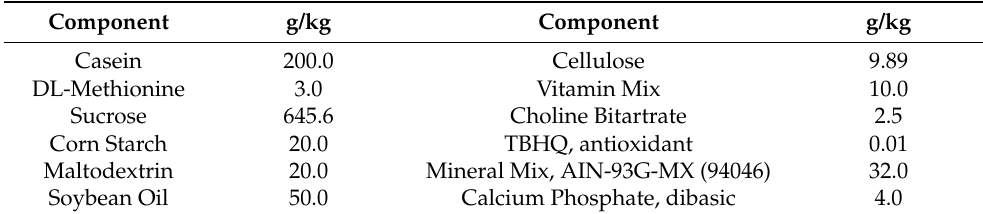
Table 1. Composition of the 70% carbohydrate